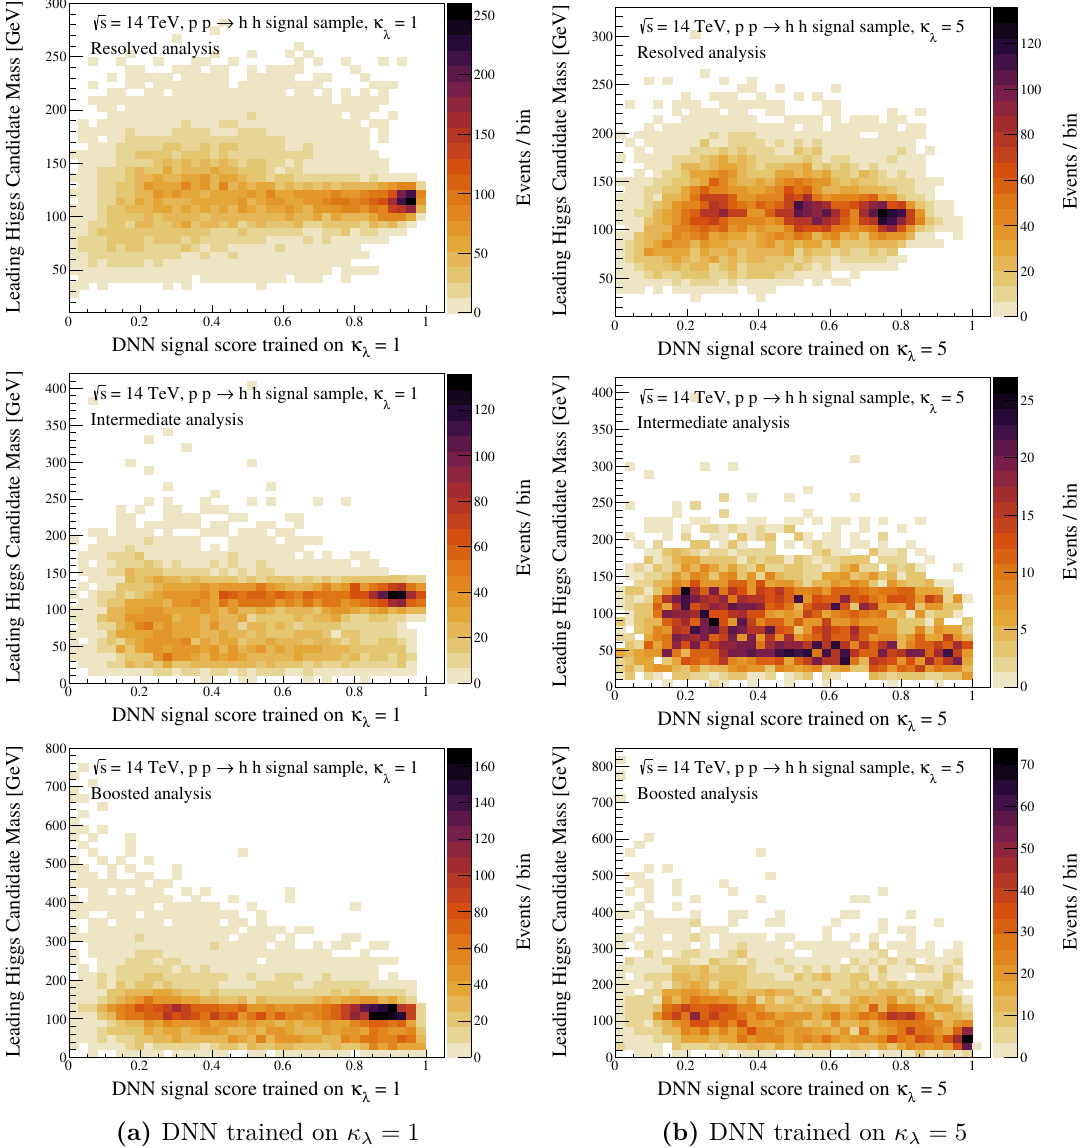
(b) DNN trained on κ λ = 5 Figure 22. The leading Higgs candidate mass vs neural network scores trained on (a) κ λ = 1 and (b) κ λ = 5 signal sample for the (upper) resolved, (middle) intermediate, and (lower) boosted analyses. The test samples used to make these distributions are an independent set of (a) κ λ = 1 and (b) κ λ = 5 signal